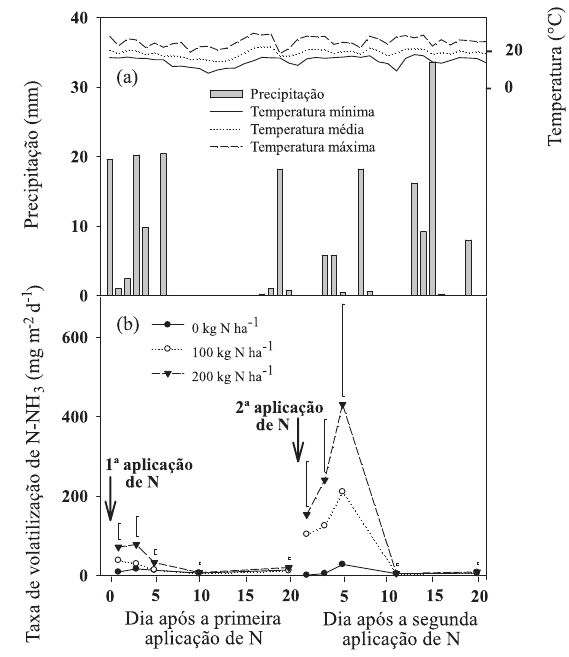
Figura 2. temperatura do ar (máxima, média e míni- ma) e precipitação pluvial no período posterior à aplicação de n-ureia (a) e taxas de volatiliza- ção de n-nH 3 oriundo do n-ureia aplicado na cultura do milho, após a primeira e a segunda aplicação de n (b). média dos tratamentos com aveia-branca e ervilhaca. as barras verticais indicam diferença mínima significativa (teste de tukey, p >